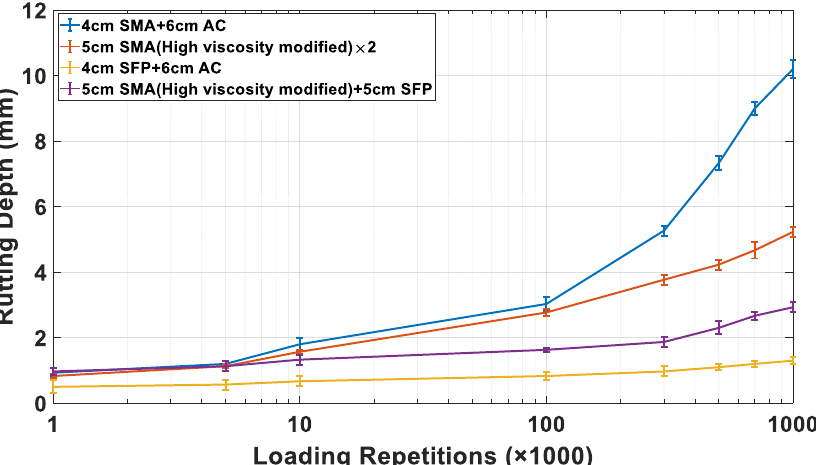
Figure 12. MMLS3 accelerated wheel tracking test results, loading repetitions are in log scale.